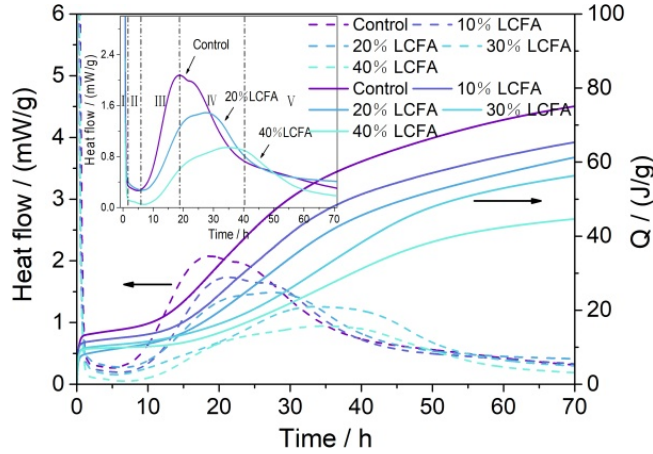
Figure 6. Hydration heat flow and cumulative hydration heat.